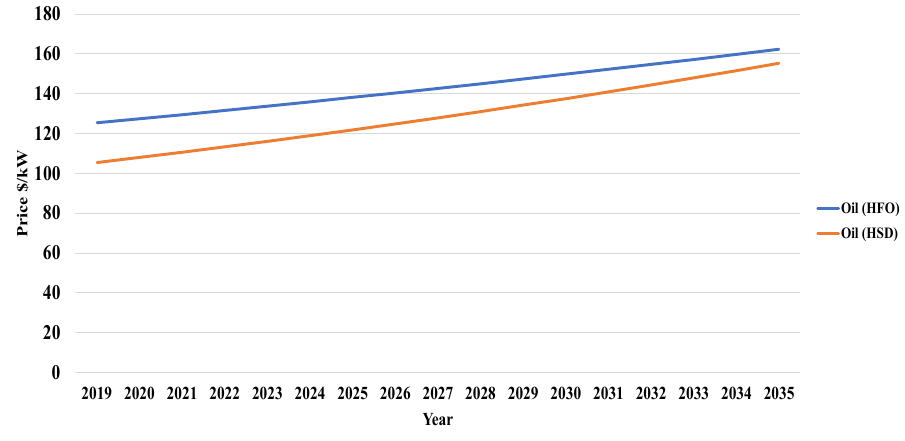
Figure 7. Variation of the variable costs with a change in oil price.